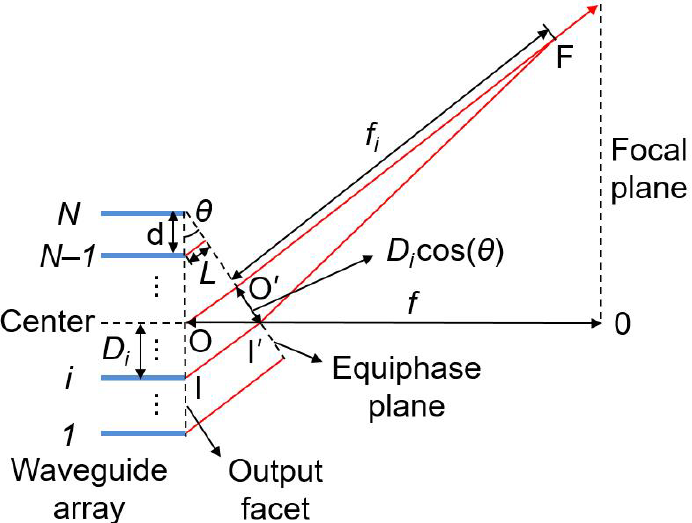
Figure 2. Illustration of the wavelength separation and beam focusing functions of a waveguide array. According to Equation (5), f i can be calculated